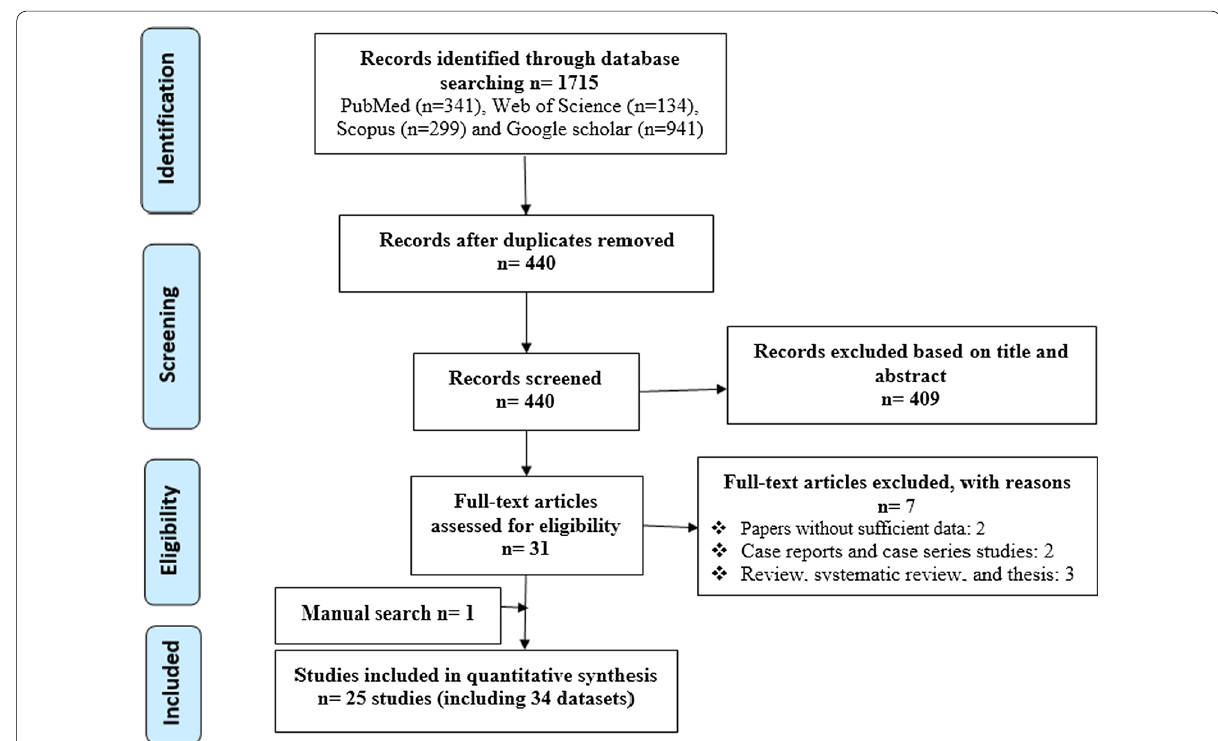
Fig. 1 PRISMA flow diagram describing included/excluded